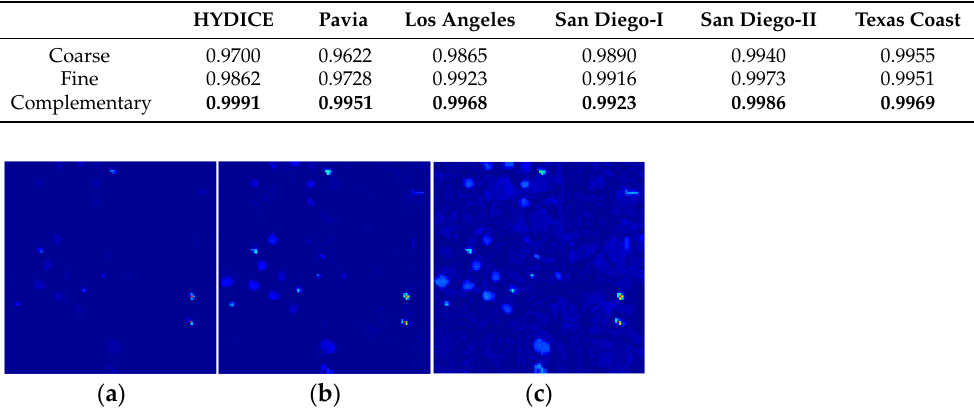
Table 2. Component analysis results for experimental datasets.